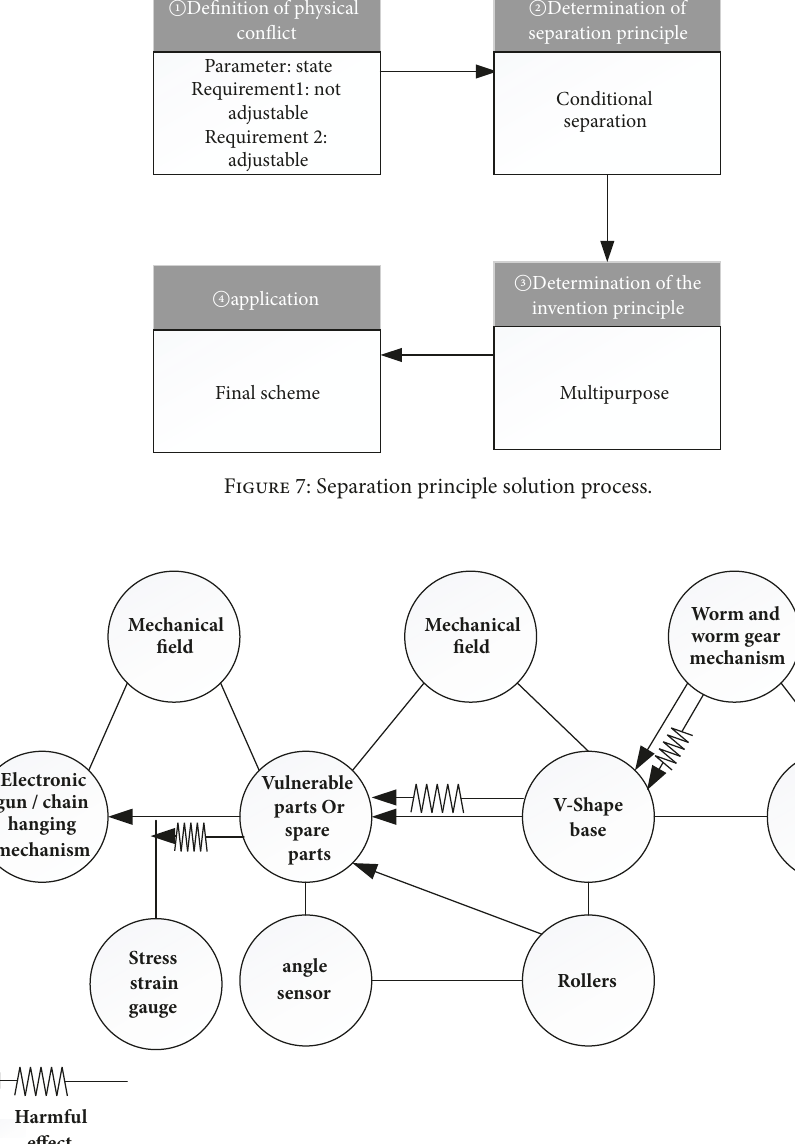
Figure 8: The original project object-field model